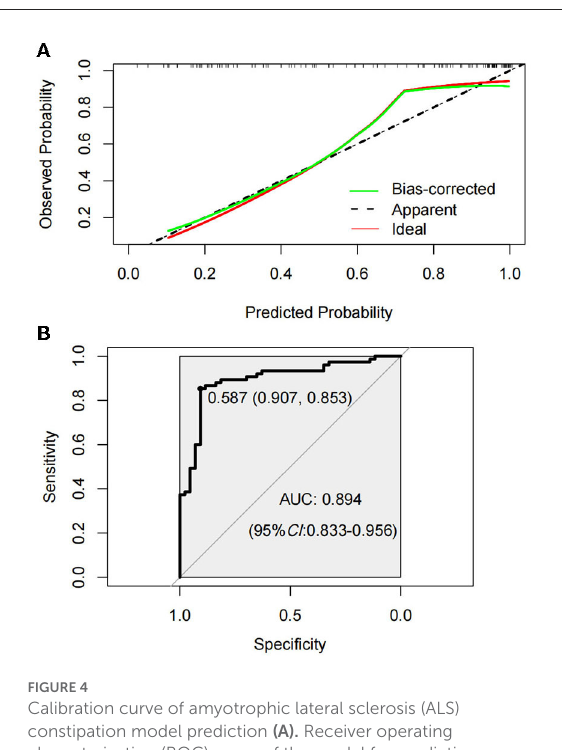
FIGURE4 Calibration curve of amyotrophic lateral sclerosis (ALS) constipation model prediction (A). Receiver operating characterization (ROC) curve of the model for predicting constipation in ALS patients (B) .